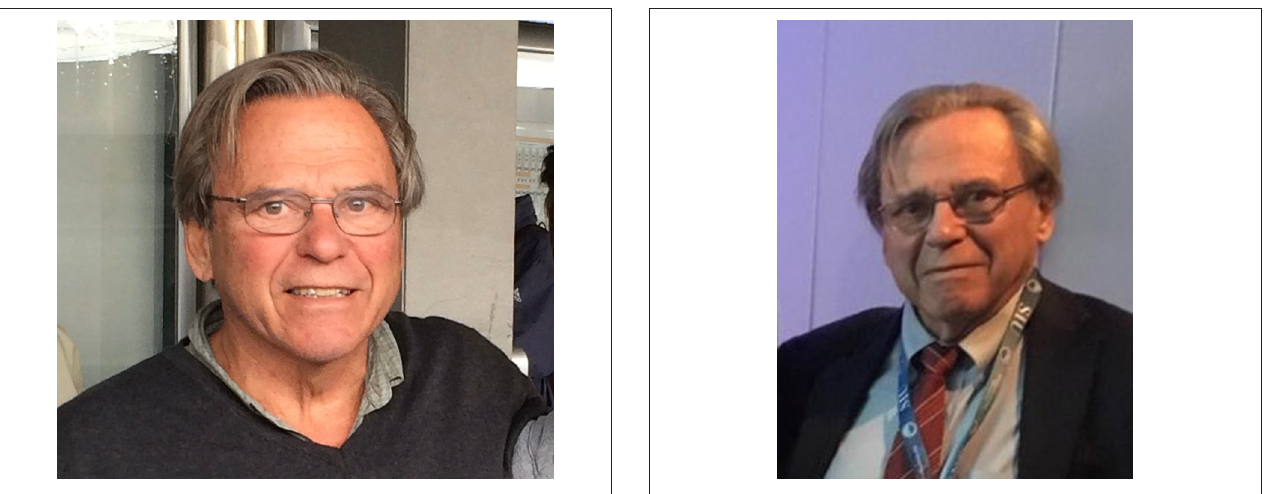
FIGURE 1 | Ricardo González. World Congress of Pediatric Surgery. 2007. Buenos Aires. Argentina.